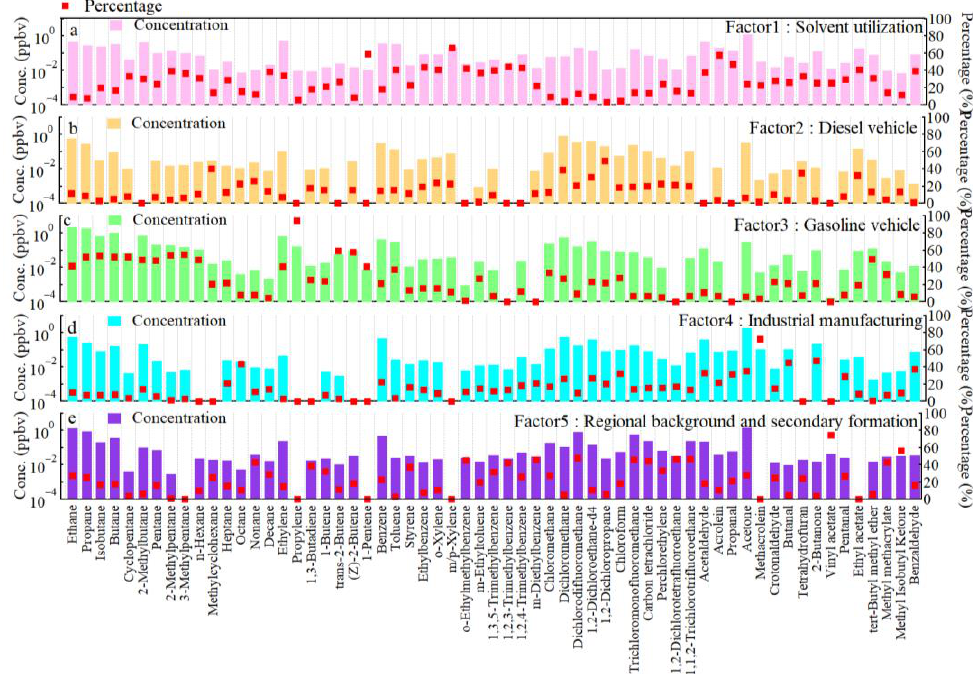
Figure 8. Source profiles of VOCs resolved from PMF in fall.